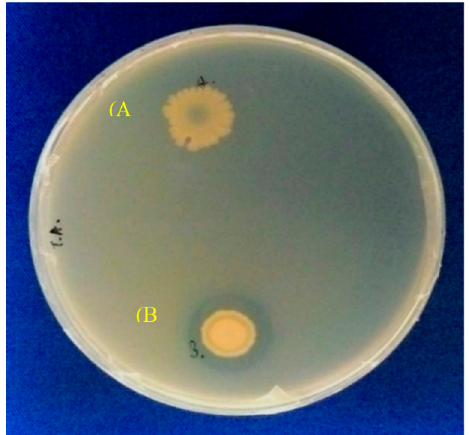
Figure 2. Tributyrin plate tests for intracellular and surface-display CALA. (A: Intracellular CALA; B: sdCALA).